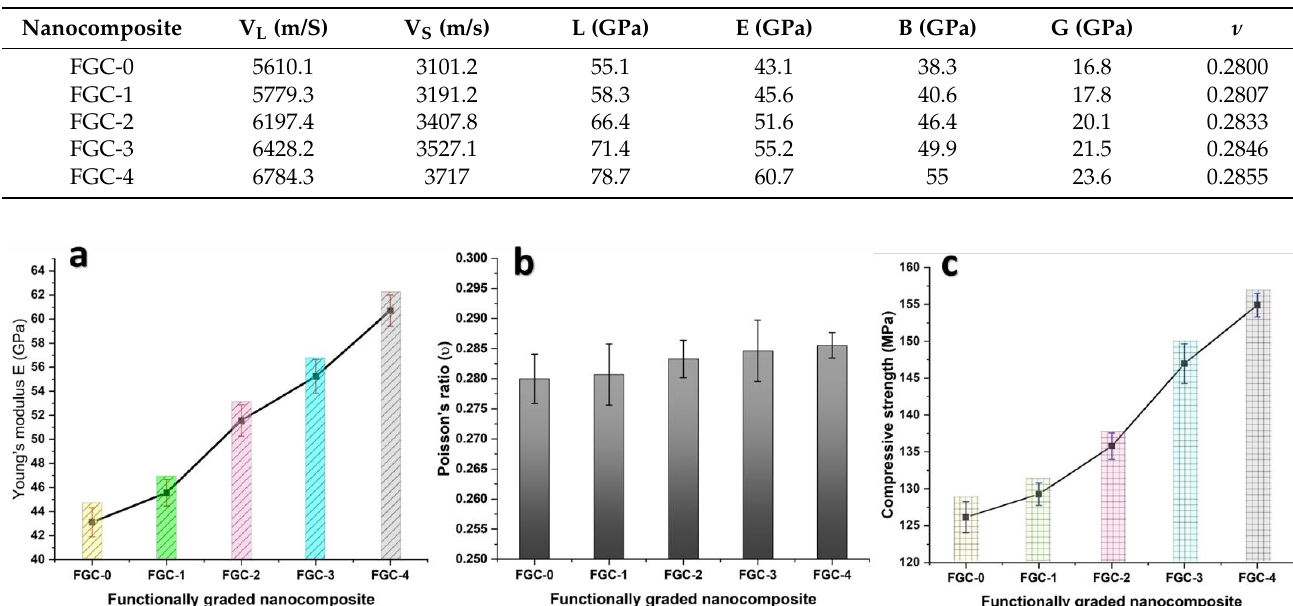
Figure 11. Microhardness of all FGCs sintered at 560 °C for 1 h in argon. Table 3. Ultrasonic velocities and elastic moduli values of different layers of FGCs.